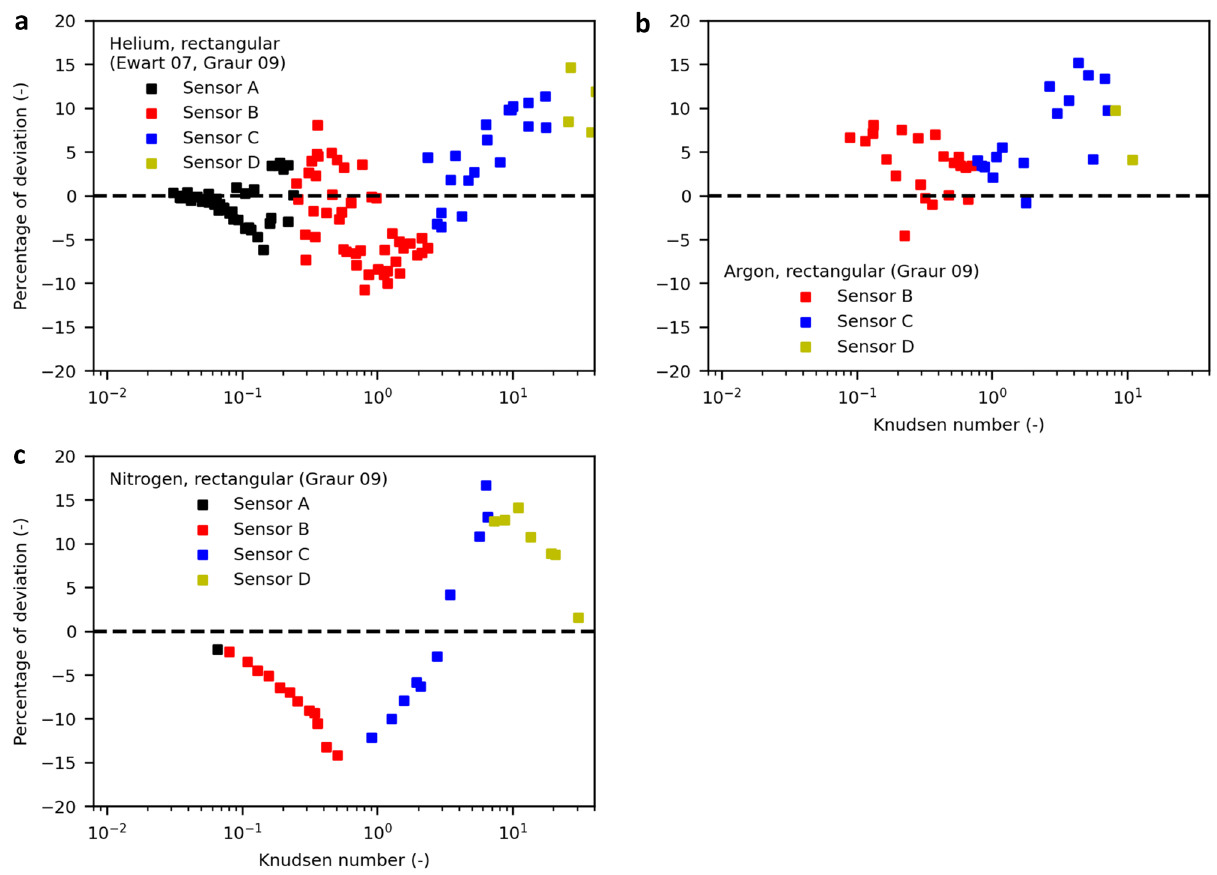
Figure 6. Deviation of modelled mass flow from experimental data for rectangular channels. The deviation shows some pattern that is strongly correlated to the pressure sensors used in different Kn